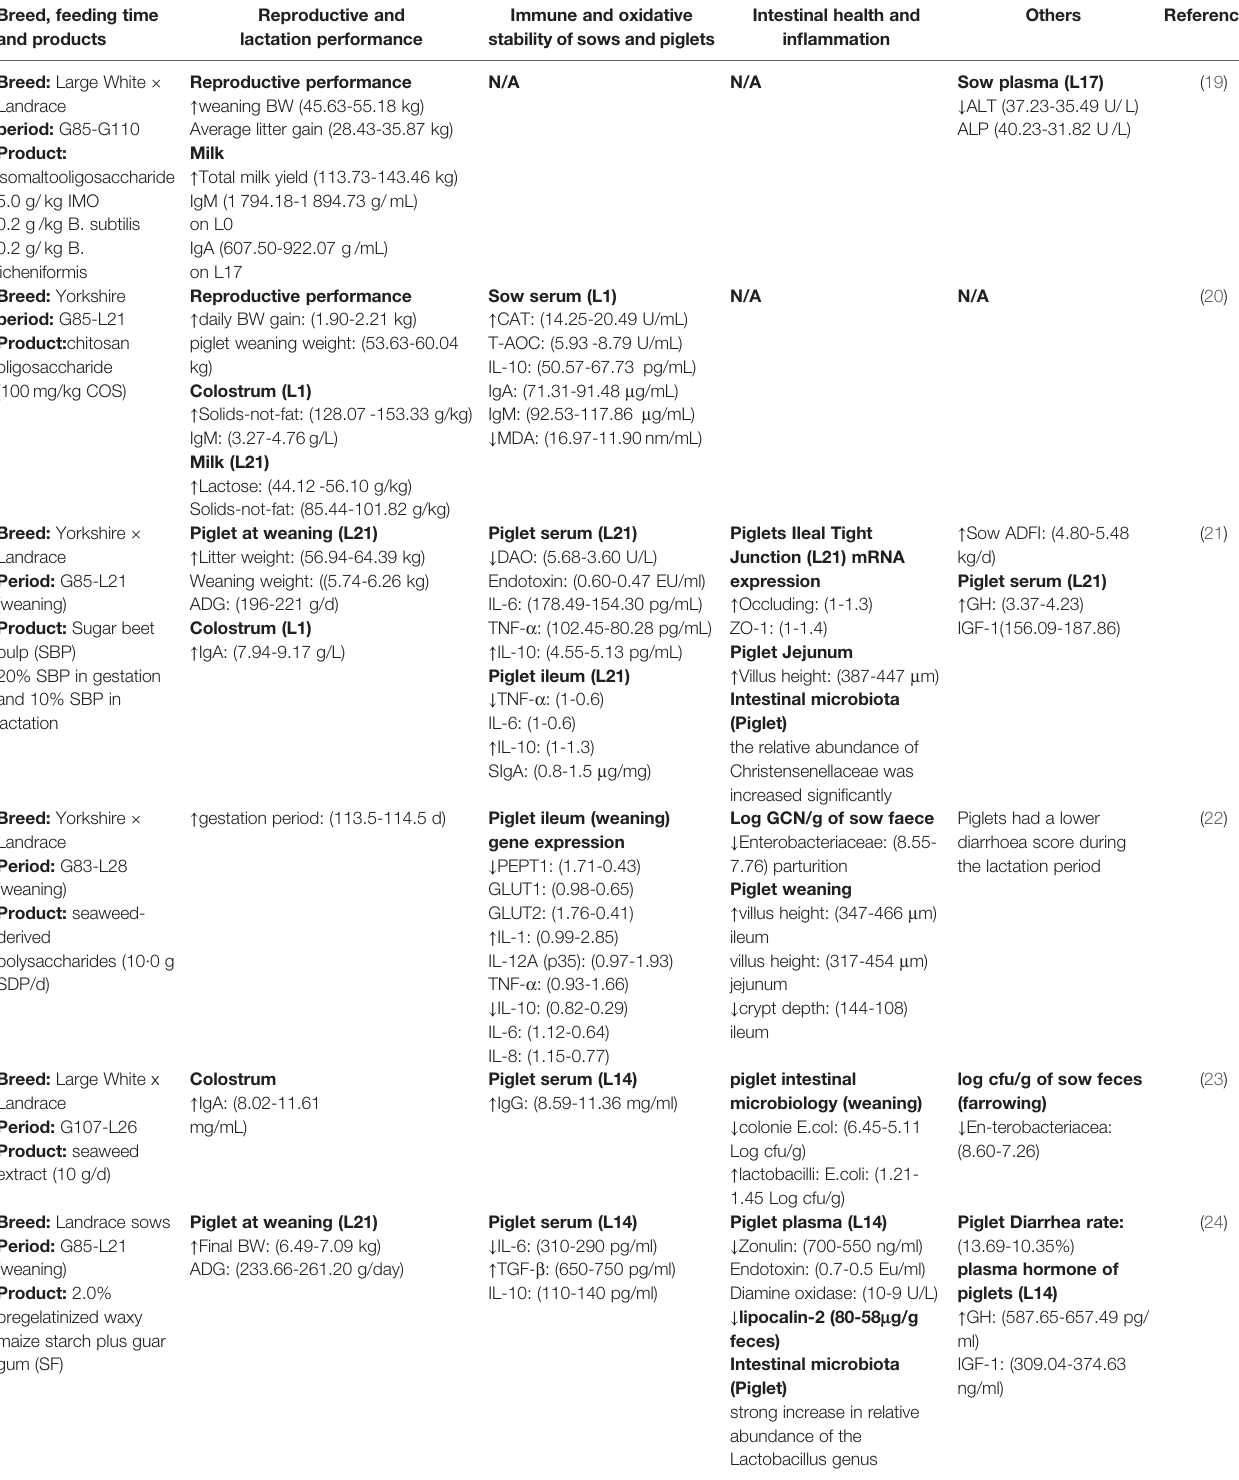
TABLE 1 | Maternal microbial and soluble dietary fi ber intake in the regulation of neonatal infection, immunity and production performance. Breed, feeding time Reproductive and Immune and oxidative Intestinal health and and products lactation performance stability of sows and piglets in fl ammation